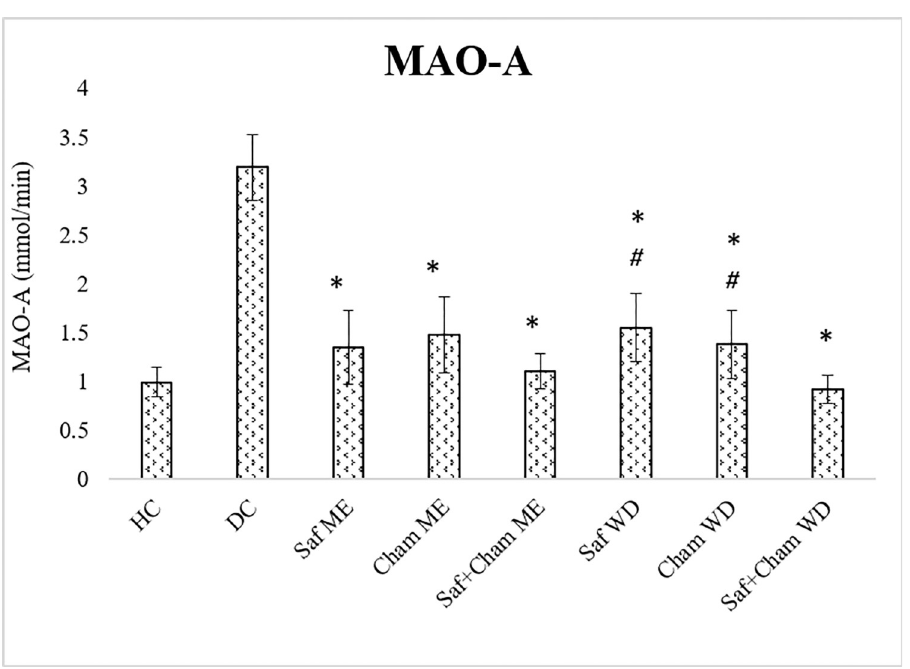
Fig 8. Effects of saffron, chamomile and their co-administration in methanolic extract and water decoction on MAO-A level in streptozotocin-induced diabetic rats. Values are presented as means ± SD (n = 10). Tukey’s test Significant values: � p < 0.05 from control DC, # p < 0.05 from Saf+Cham WD.